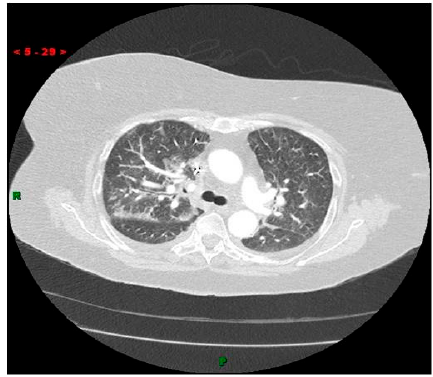
Figure 2. Computed Tomography (CT) scan of the thorax showing numerous pulmonary radiodensities with suspected cardiac radio ‐ densities.